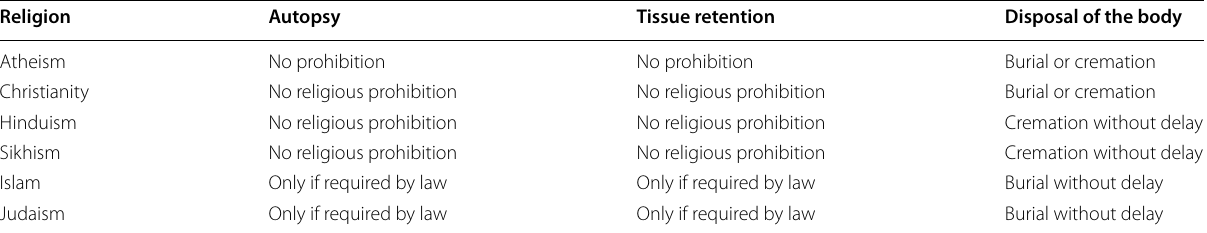
Table 1 Religious attitudes towards post-mortem investigation [59]